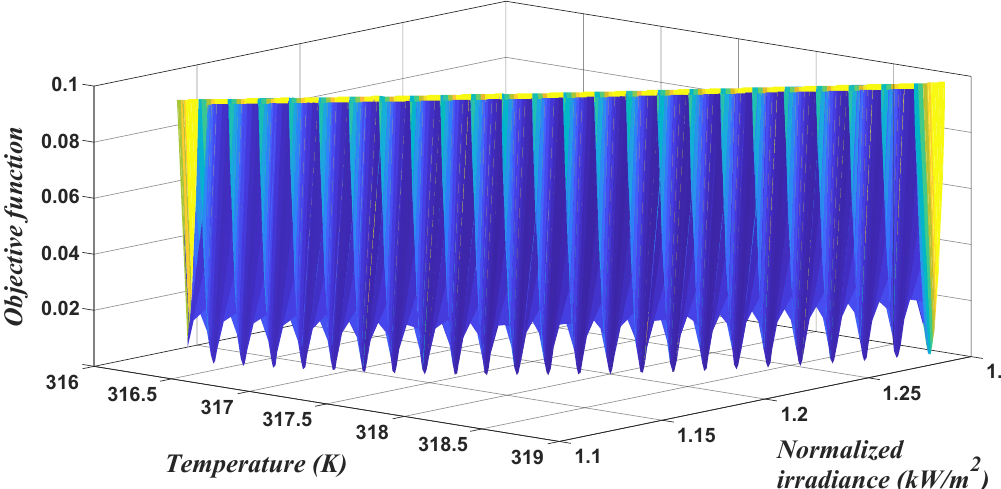
Figure 8. Objective function on the right part of the I - V